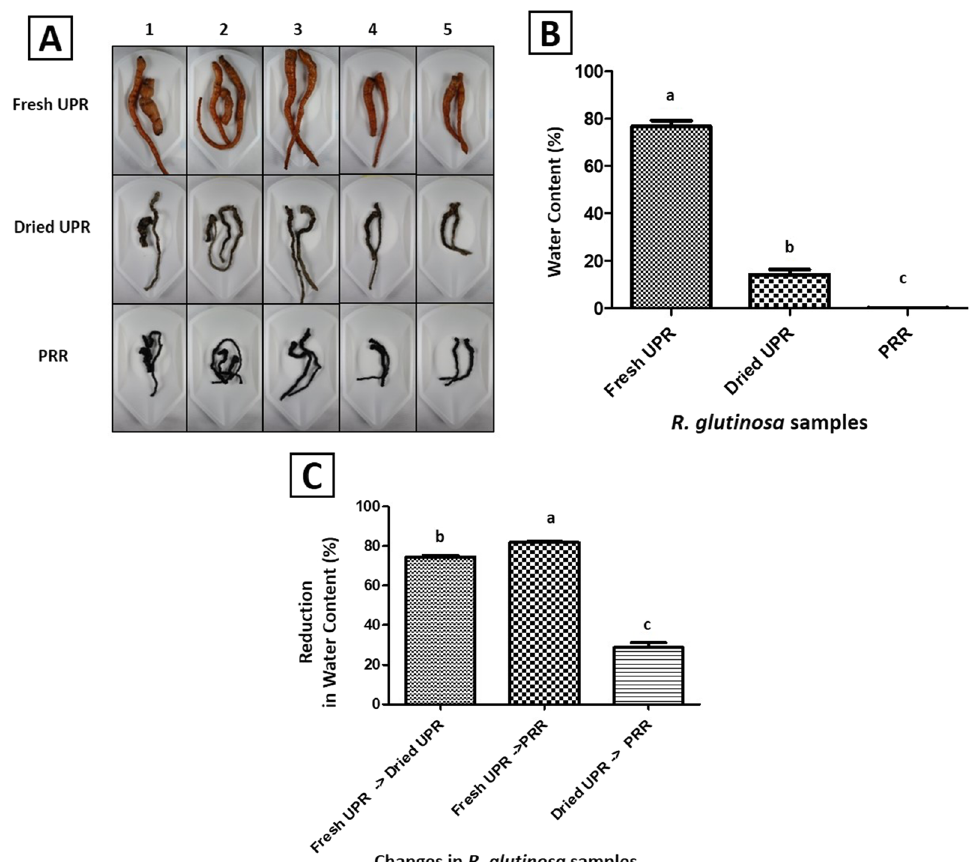
Fig. 2 The changes in biomass root morphology and water content of R. glutinosa samples. a Changes in root morphology appearance of R. glutinosa samples. b The water content of R. glutinosa samples. c . Water content loss of R. glutinosa samples during processing. * UPR Unprocessed R. glutinosa , PRR Processed R. glutinosa. Values are presented as means standard deviation. Same letters are not significantly different by Tukey’s test ± and p =